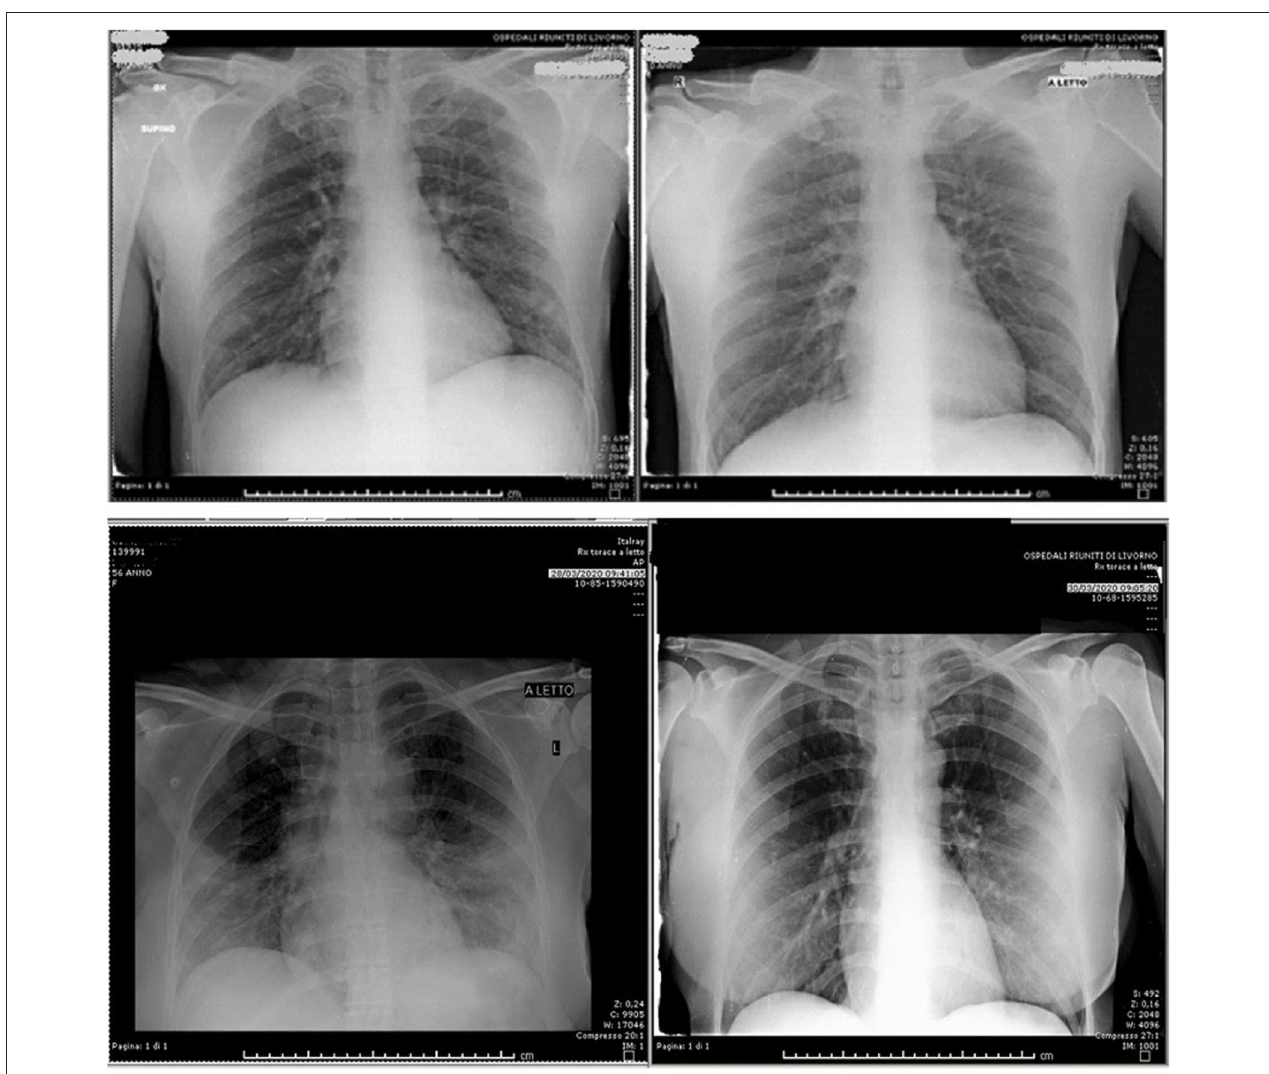
FIGURE 4 | CXR at T0 and after 48h of ruxolitinib treatment in two